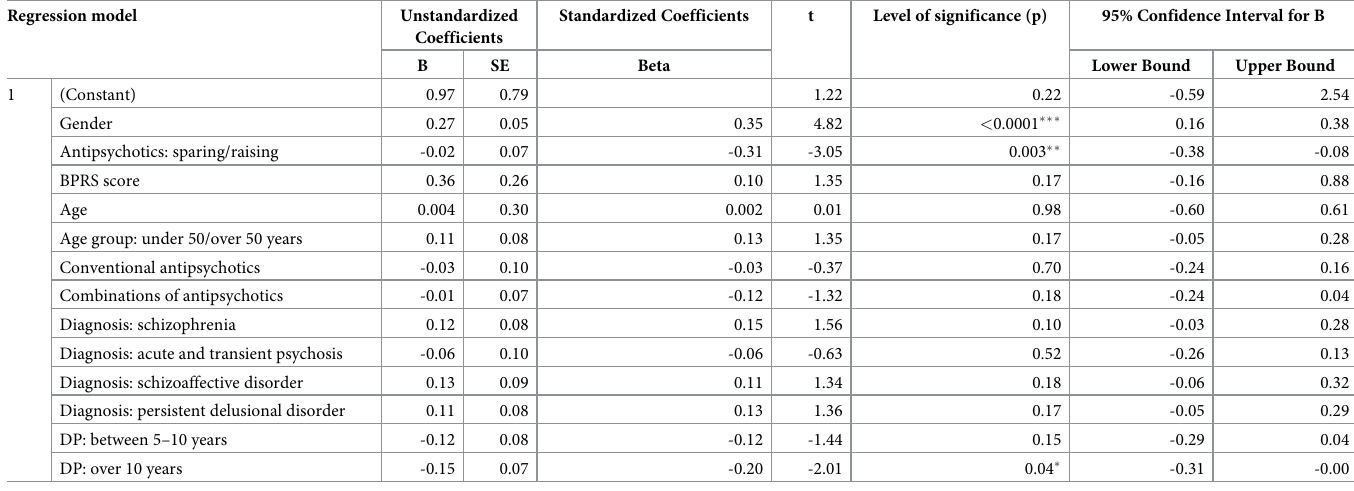
Table 6. Multiple regression